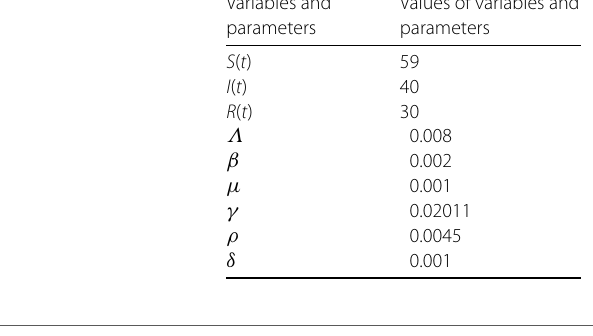
Variables and parameters